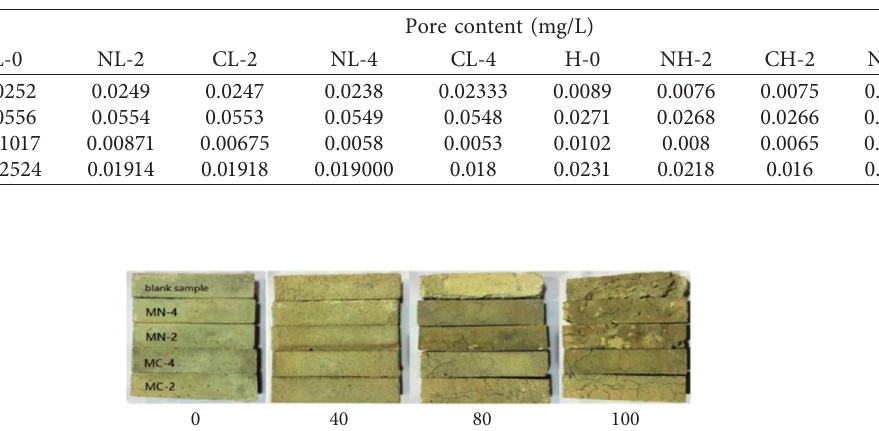
Figure 9: The appearance change of mortar under dry-wetting cycles.